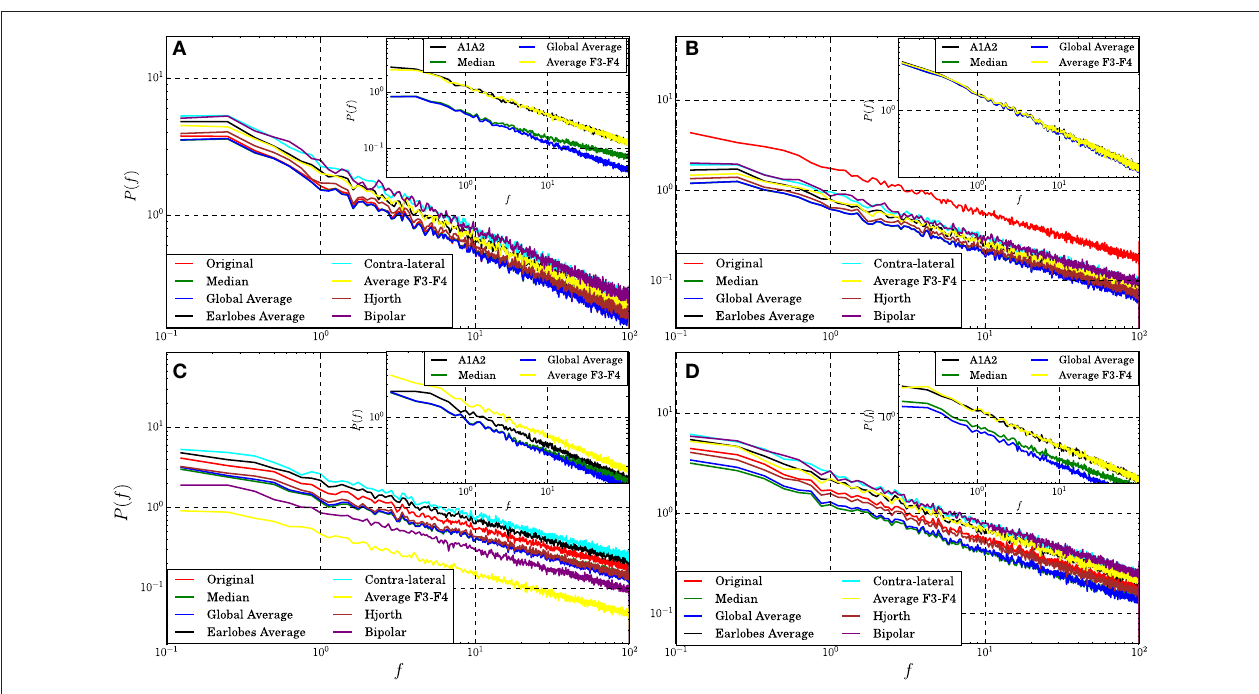
FIGURE 6 | Power spectra averaged over all active electrode signals transformed to different reference schemes estimated for synthetic data derived from Model 1 (A) , Model 2 (B) , Model 7 (C) , and Model 8 (D) . The insets show the power spectra of some of the corresponding reference